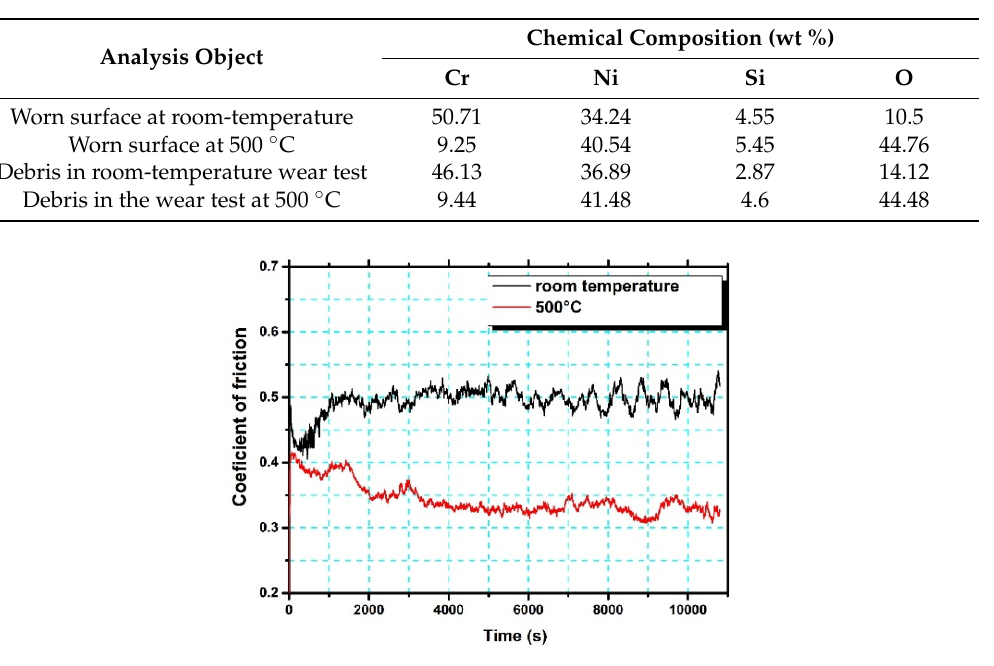
Figure 15. Coefficient of friction as a function of time for the Cr 13 Ni 5 Si 2 coating and the Si 3 N 4 counterpart ball at room temperature and at 500 °C.